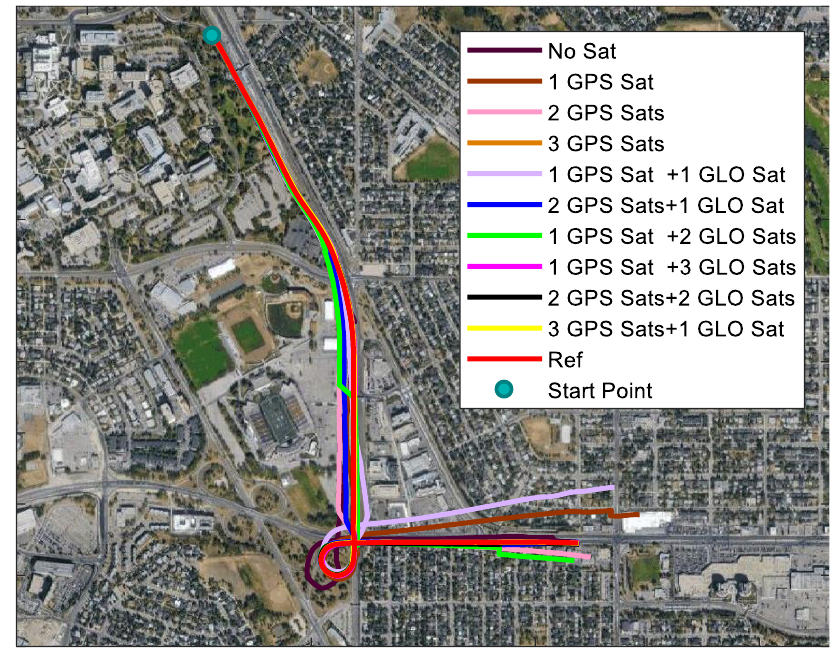
Figure 11. Trajectories of using different GPS and GLONASS satellites.